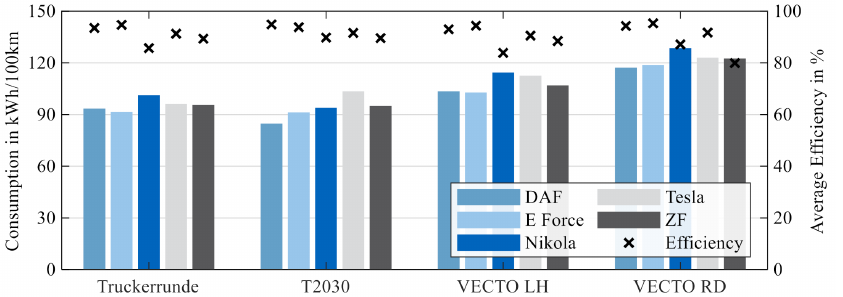
Figure 5. Varying driving cycles with different characteristics have an influence on energy con- sumption and average electric machine efficiency. While Truckerrunde and T2030 do not include stops, both VECTO cycles include multiple stops with varying times (LH: 67 s and RD: 746 s). The spreadsheet containing the results is provided as Supplementary